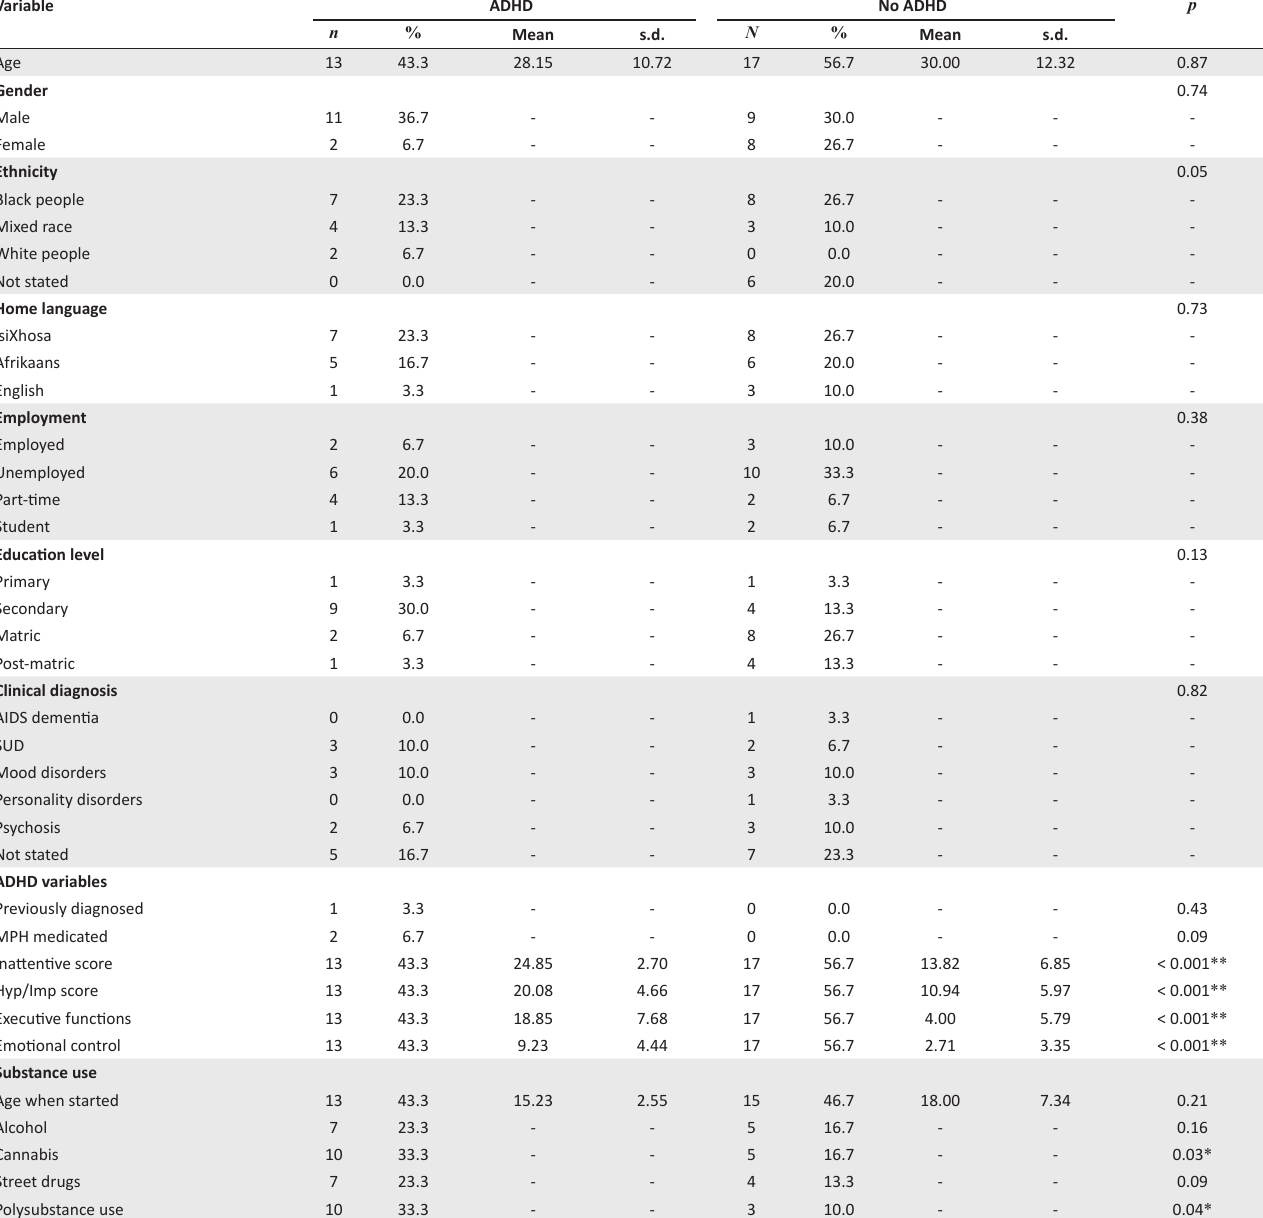
TABLE 1: Comparison between attention-deficit/hyperactivity disorder-positive and attention-deficit/hyperactivity disorder-negative screened psychiatric patients.